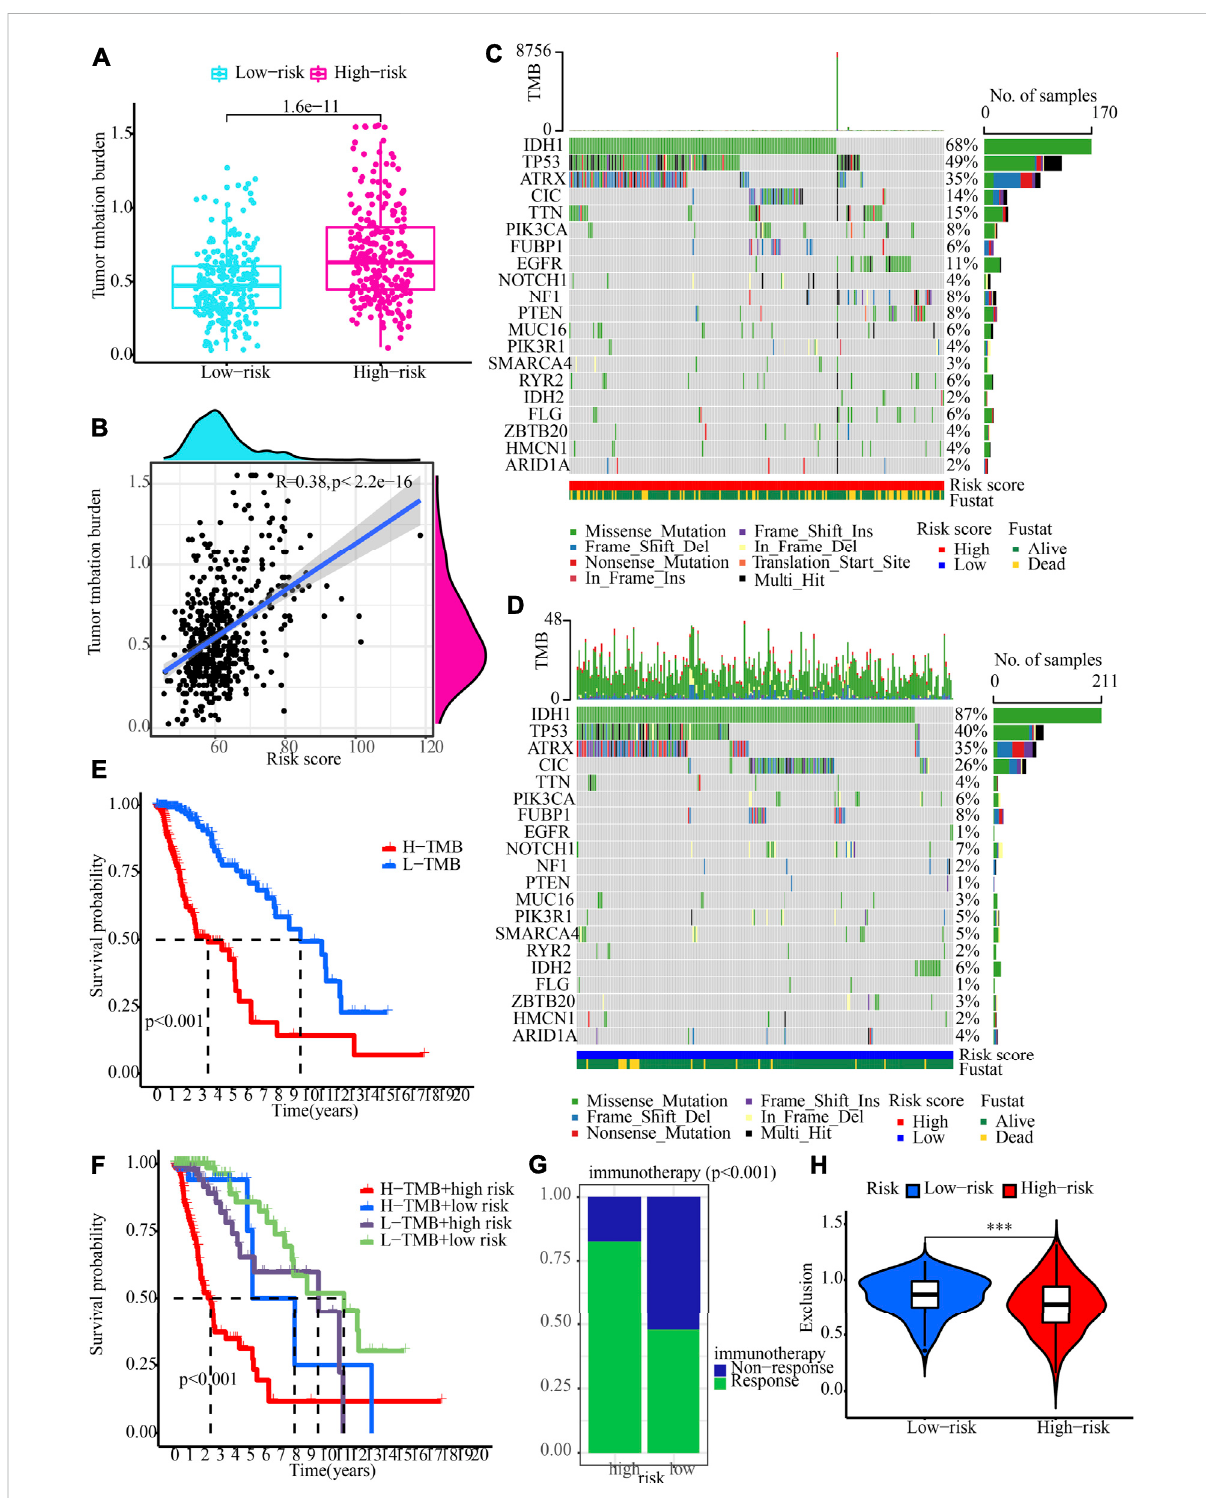
FIGURE 9 TMB analysis and immunotherapy response prediction in the training cohort. (A) The variation between high- and low-risk groups in terms of TMB. (B) An analysis of the correlation between risk score and tumour mutation burden (C,D) OncoPrint of frequently mutated genes in high- and low-risk groups. (E) TheKaplan-Meiercurveofoverallsurvivalforpatients, asshownbysamplescategorisedaccordingtotheirTMBscore. (F) OSfor patients de fi ned bythesamplescategorisedbyboththeir riskscore and their TMB score,as shown bytheKaplan-Meiercurve. (G) The variation in immunotherapy response in low- and high-risk groups. (H) Immunotherapy response prediction in the training